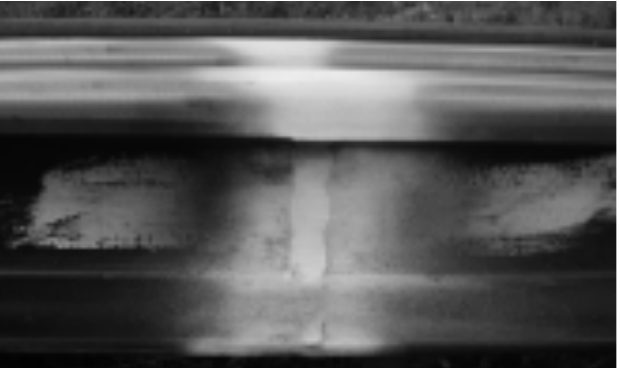
Figure 11. Penetration testing of rail joints. Source: own.